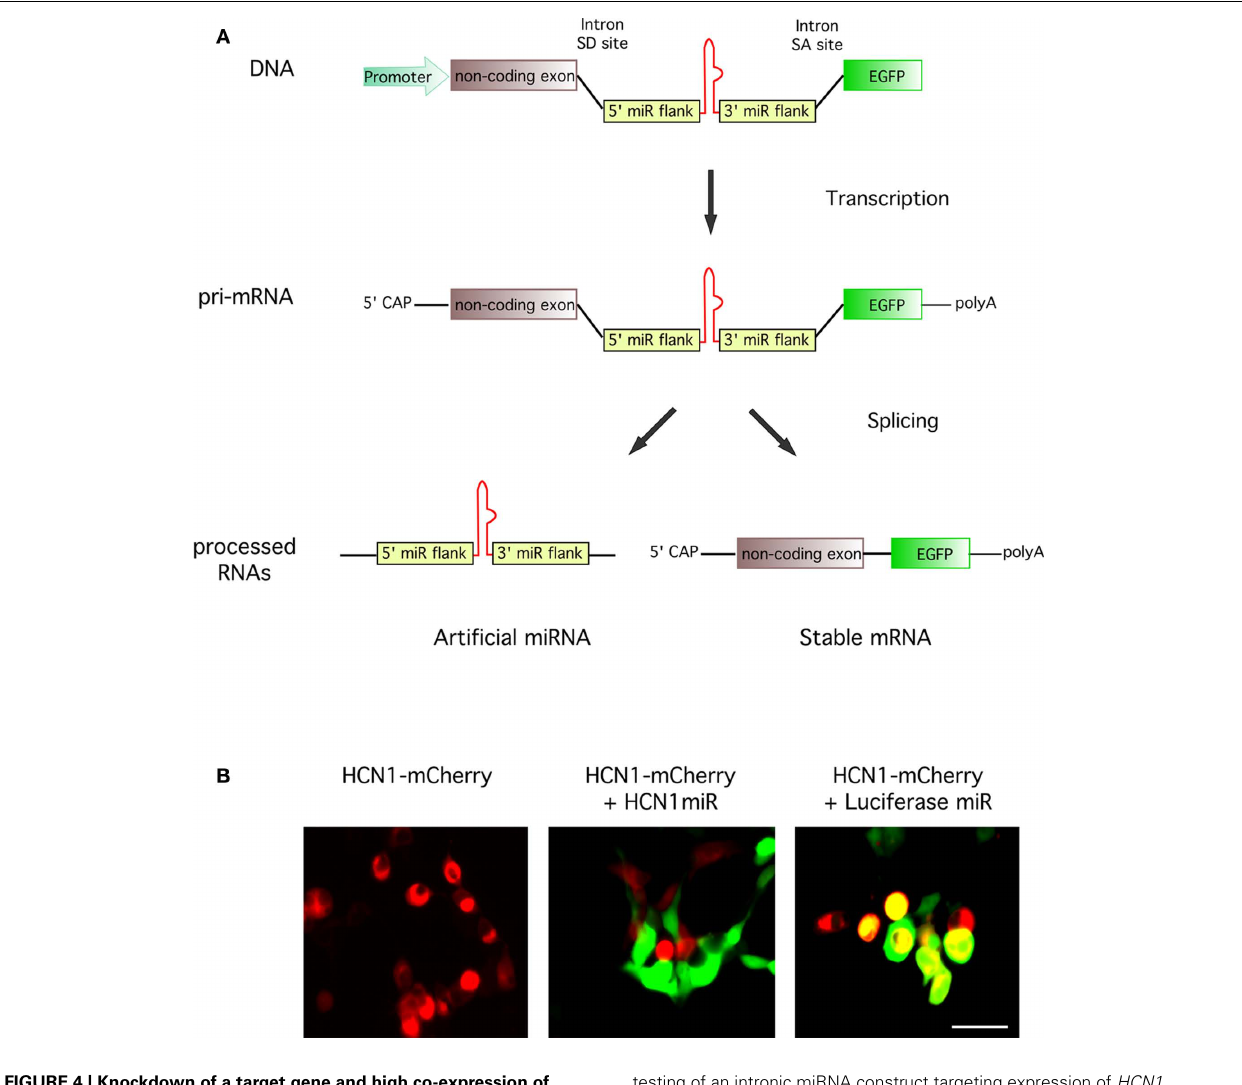
FIGURE 4 | Knockdown of a target gene and high co-expression of reporter gene following expression of constructs containing intronic artificial miRNAs. (A) Schematic illustrating processing of an artificial intronic miRNA construct. DNA transcription produces a pri-mRNA with an intronic miRNA. Cellular splicing excises the miRNA component ready for downstream processing, leaving a stable mRNA with a 5 (cid:2) CAP and polyA tail for the expression of EGFP. (B) In vitro